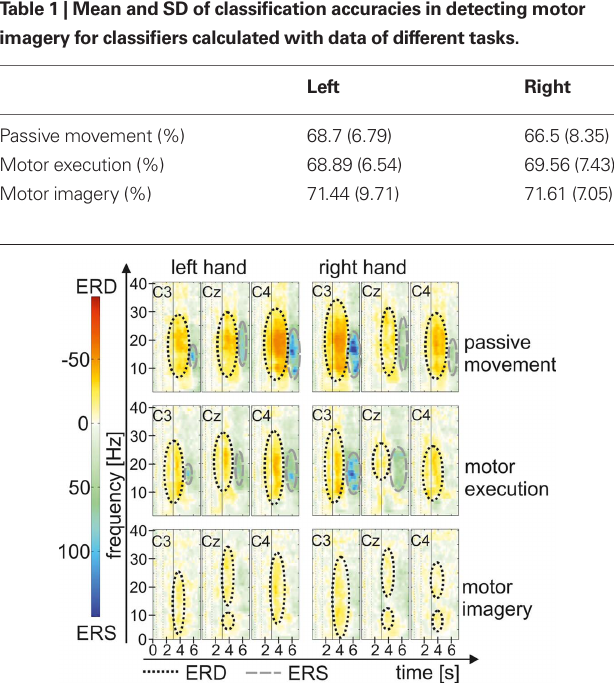
Figure 7 | grand average time–frequency map for every task.